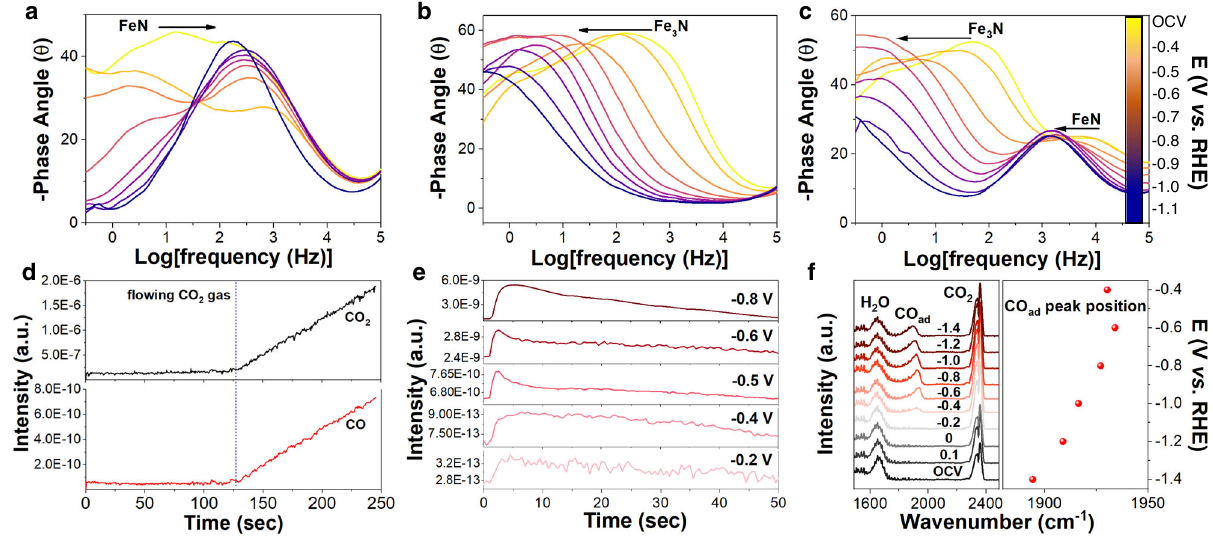
Fig. 4 | In situ spectroscopic studies of Fe-N catalysts and CO 2 RR. a – c Bode phase plots of FeN a , Fe 3 N b , and FeN/Fe 3 N c at different reduction potentials. In situ DEMS plots showing the increasedpresence of COwith increased fl owing CO 2